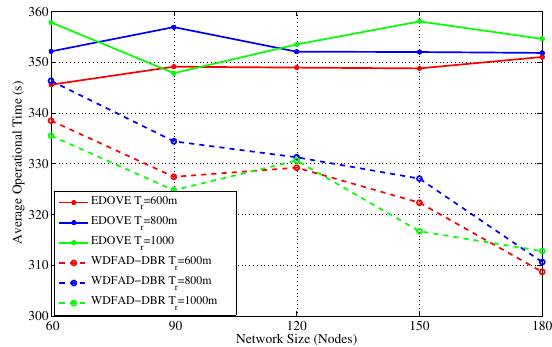
Figure 18. Average network operational time versus the network sizes.